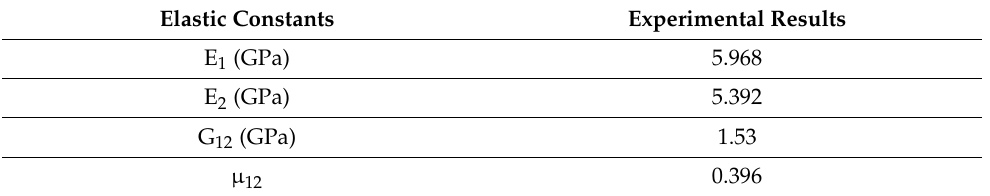
Table 5. Elastic constants of WFBE